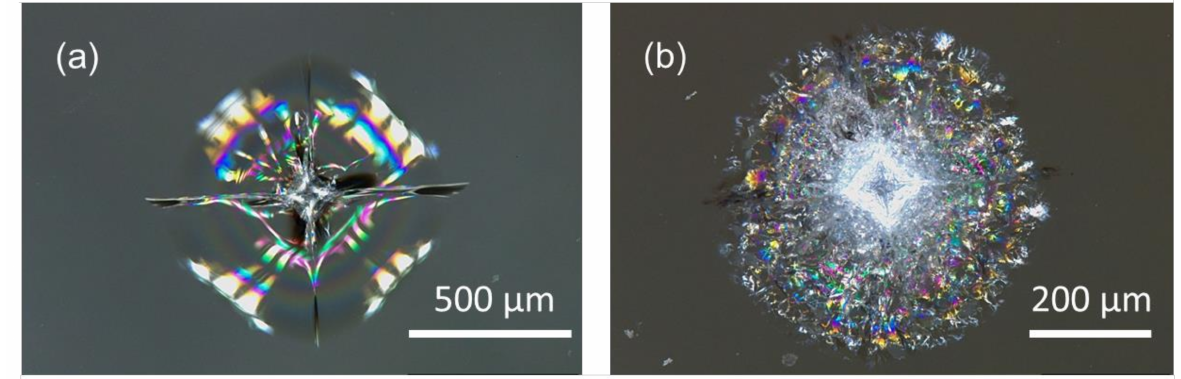
Figure 2. Optical microscopy image of cracks and around the imprint of the Vickers indentation at 98 N ( a ): soda-lime–silica (SLS), ( b ): CaO–Al 2 O 3 –SiO 2 (CAS) glass-ceramic (GC) [26].